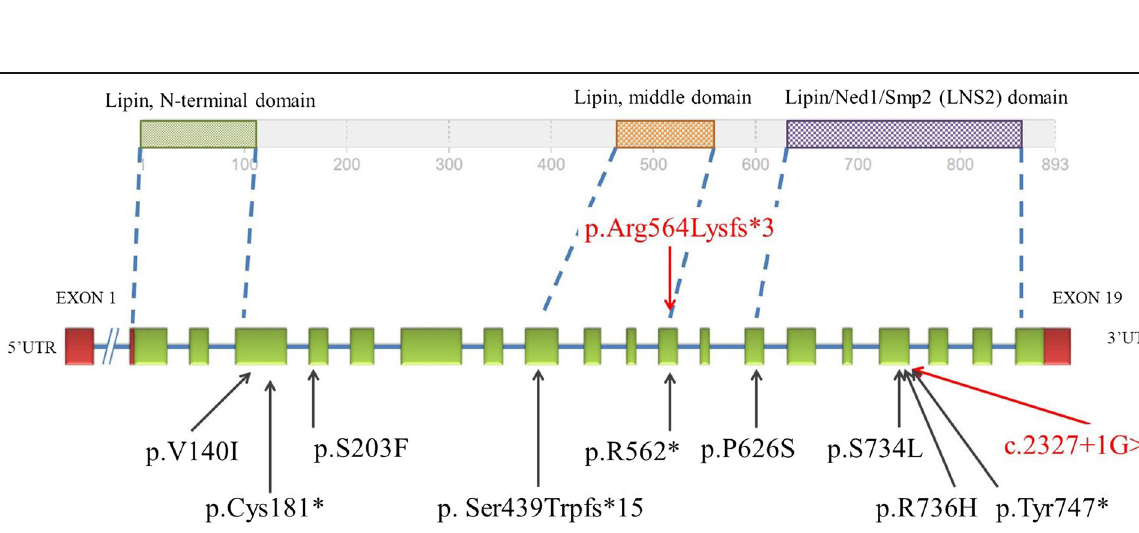
Fig. 2 Distribution of variants in exonic location of LPIN2 and domain structure of the Lipin2 protein The structure of the protein is shown in the upper row with crucial domains, drawn approximately to scale. The structure of the LPIN2 is shown in the lower row. Two structures are linked by a dashed line to indicate exonic locations of respective domains. Variants above (red) are reported in this study. Variants shown in black below are previously reported in the literature. c.2327 + 1G > C has already been reported by Al-Mosawi (2007)